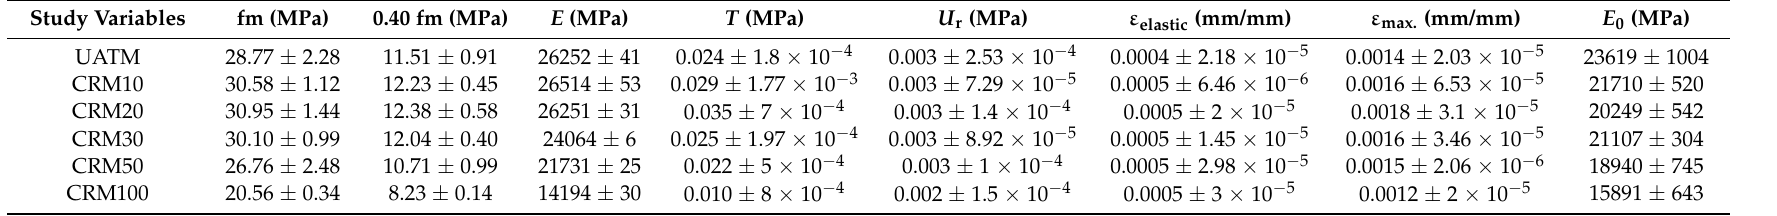
Table 4. Properties of σ - ε of the